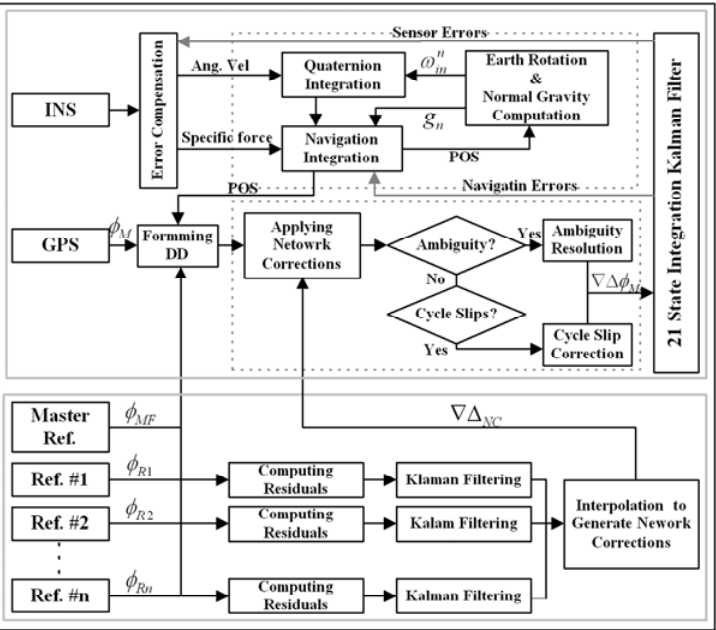
Figure 1. Configuration of the tightly-coupled GPS/INS integration using GPS multiple reference